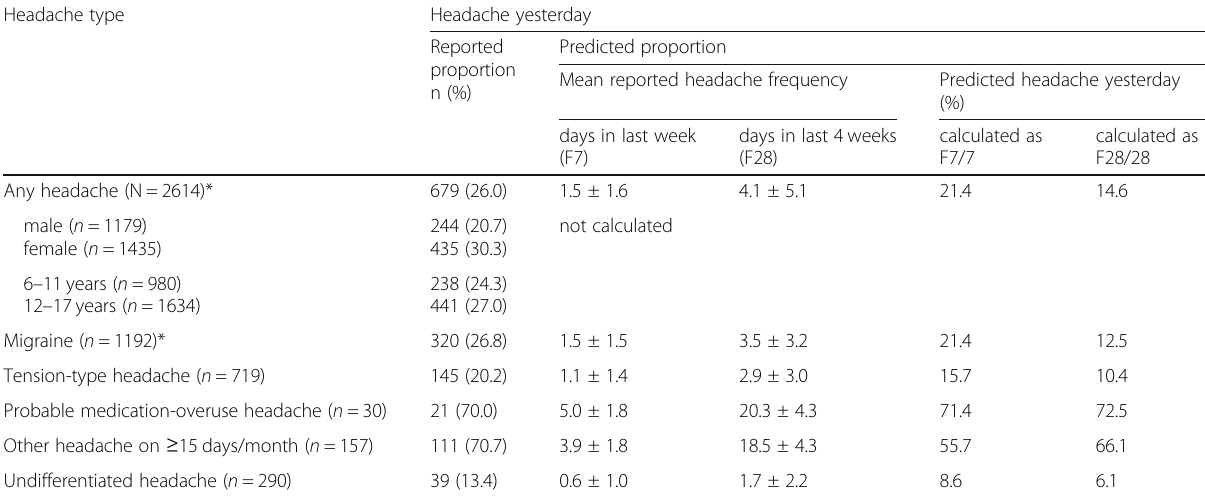
Table 5 Proportions of those with headache reporting headache yesterday, overall and by age, gender and headache type, and predicted proportions, overall and by headache type ( N =